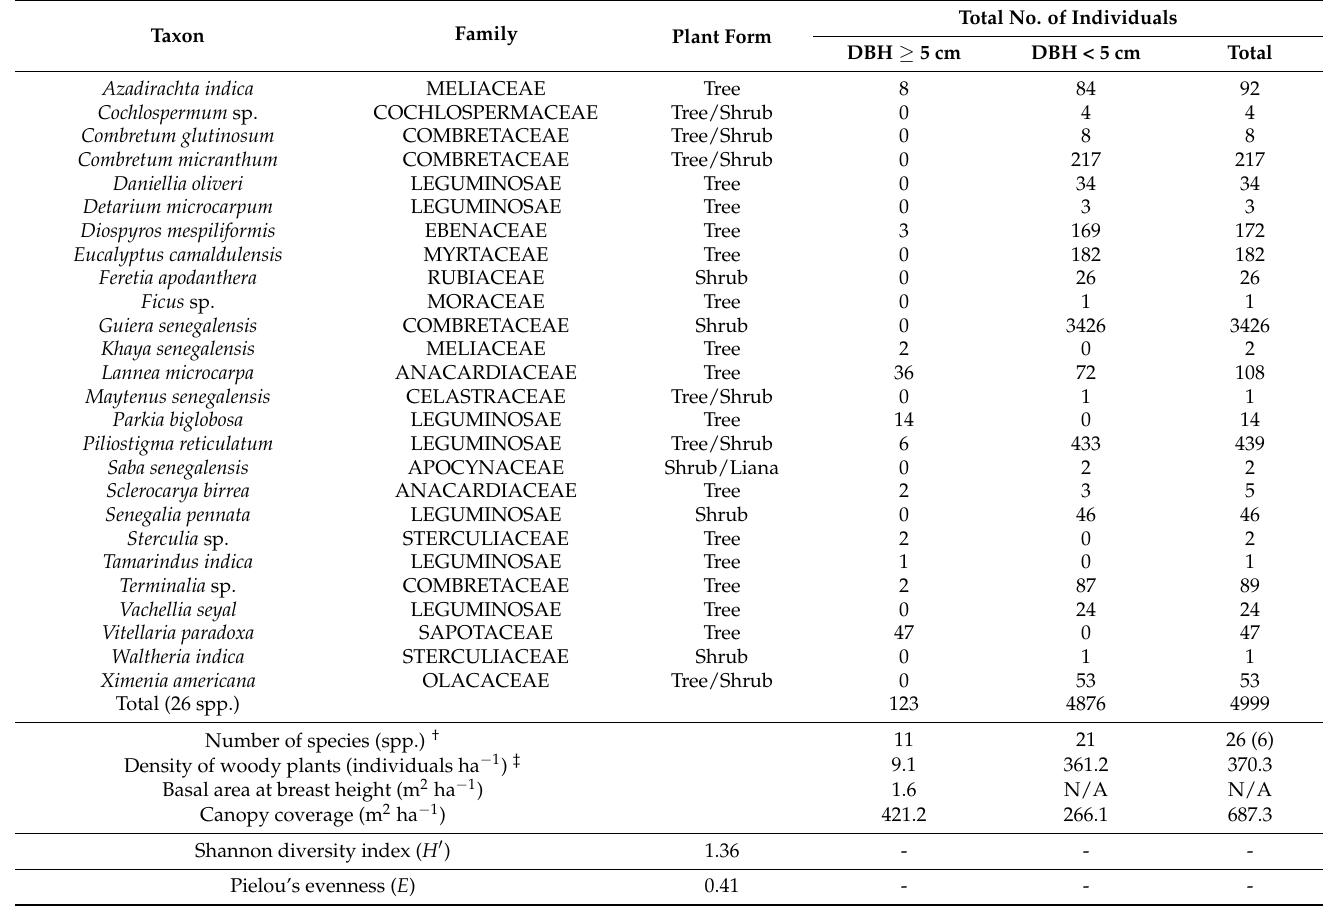
Table 1. Composition of woody vegetation along the 54-quadrat transect (total area = 13.5 ha). Taxon